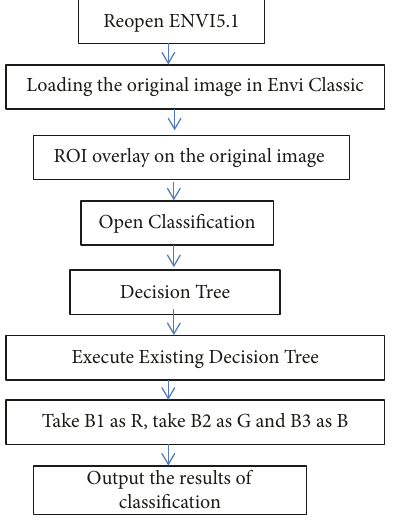
Figure 7: Flowchart of decision tree classification in Envi .